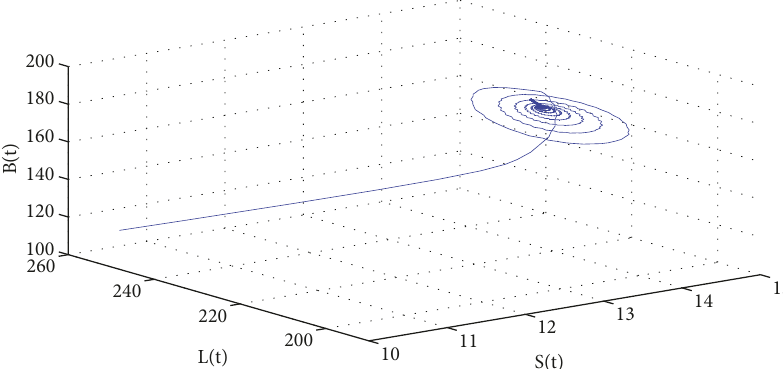
Figure 2: Dynamic behavior of system (61): projection on S-L-B with 𝜏 = 3.2575 < 𝜏 0 = 3.4685